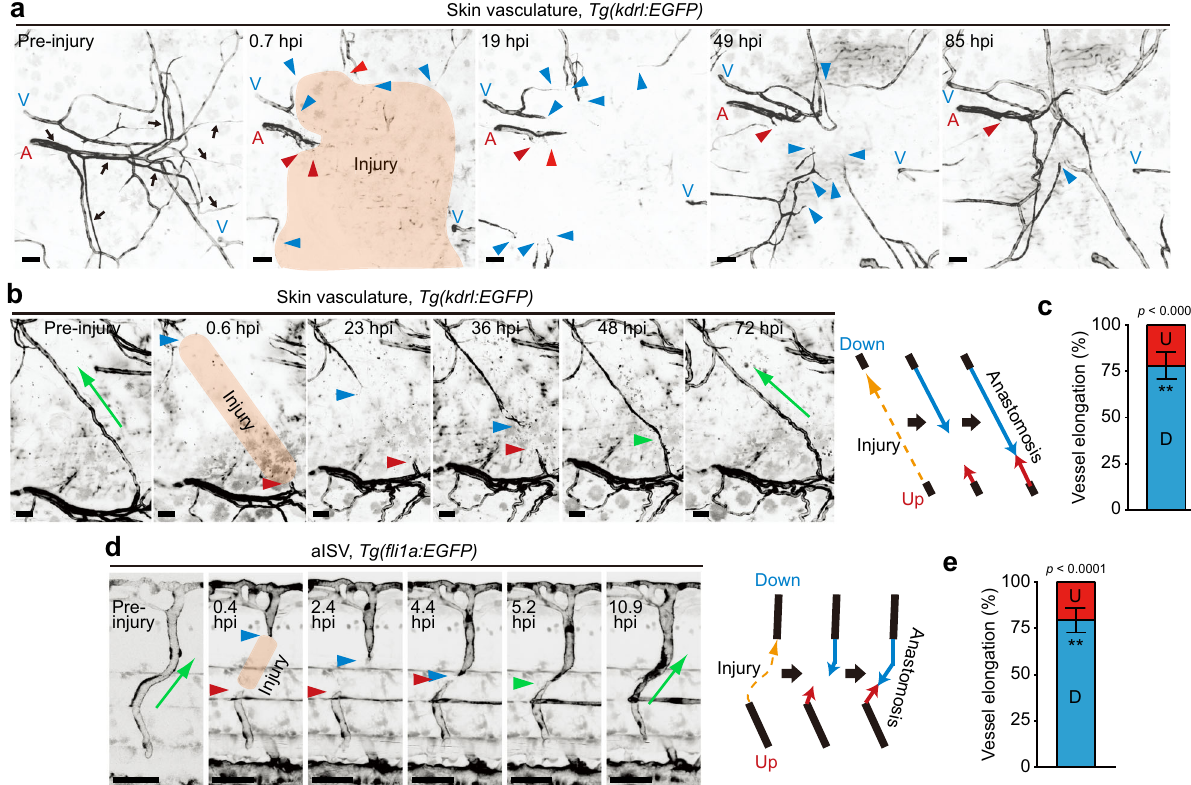
Fig. 1 Severed blood vessels elongate downstream, not upstream, from blood fl ow during wound angiogenesis. a , b Time-lapse confocal images of angiogenesis in injured skin of Tg(kdrl:EGFP) adult zebra fi sh. Confocal z -projection images of cutaneous vasculature before injury (Pre-injury) and at